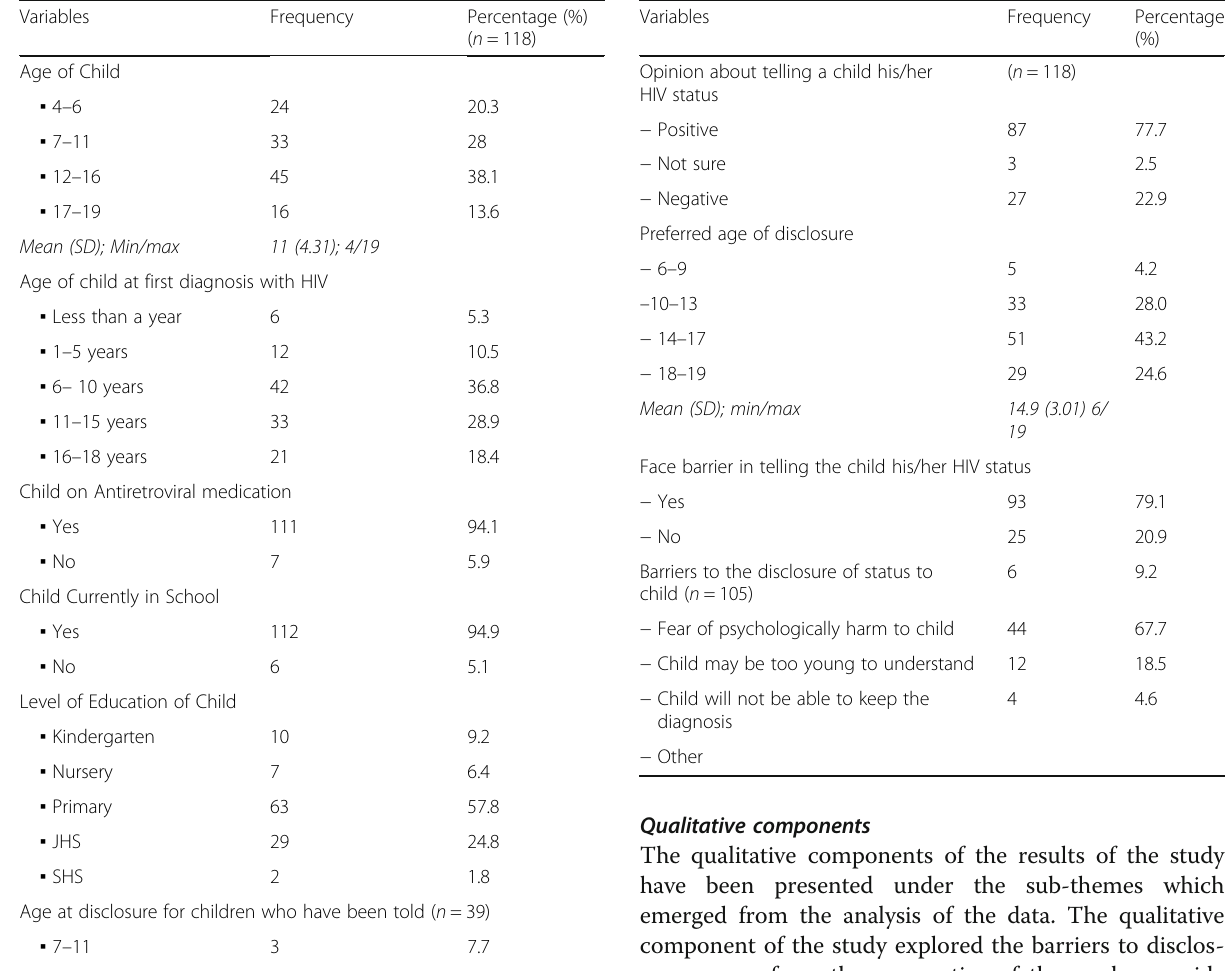
Table 3 The barriers to disclosure of HIV status to